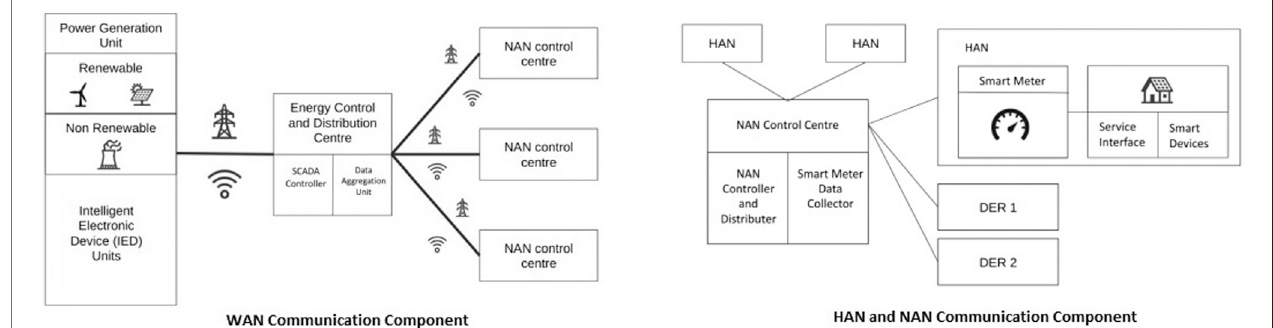
FIGURE 3 | WAN, HAN and NAN layout.